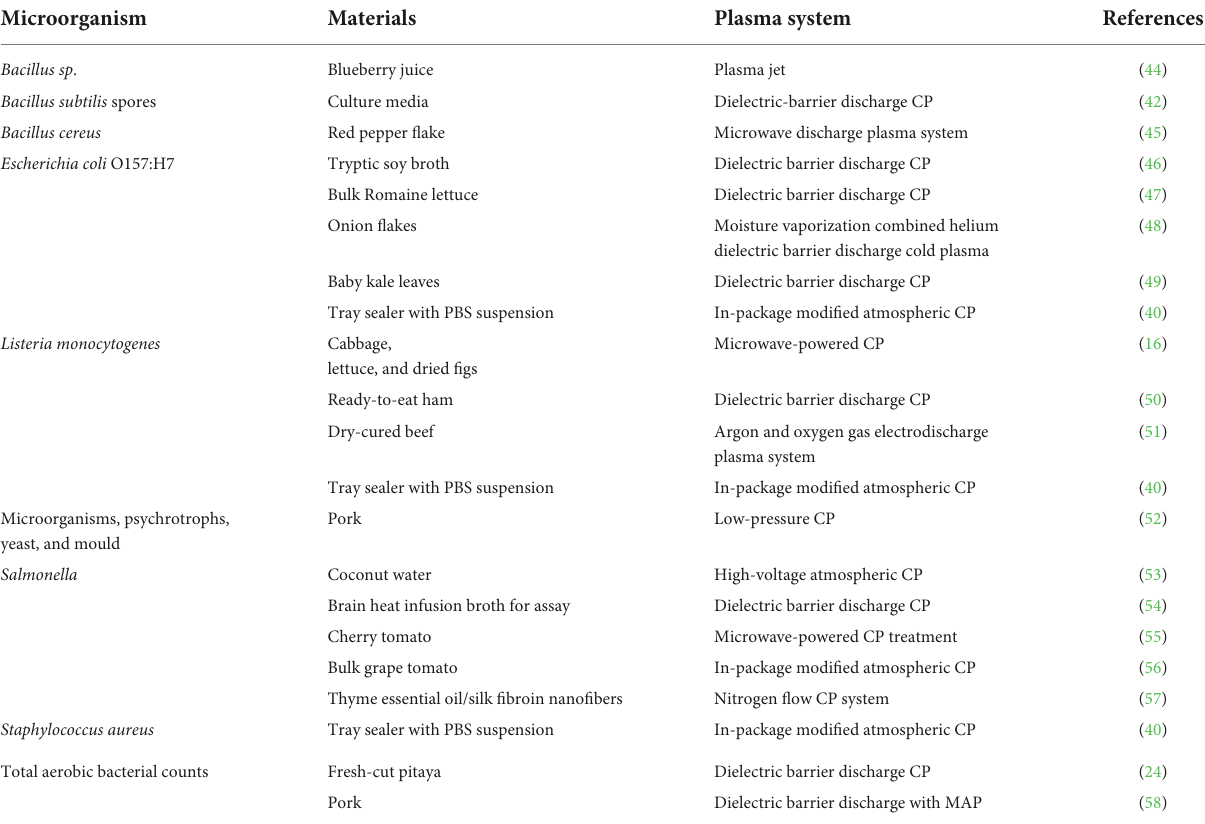
TABLE 3 Microorganism inactivation with cold plasma (CP)